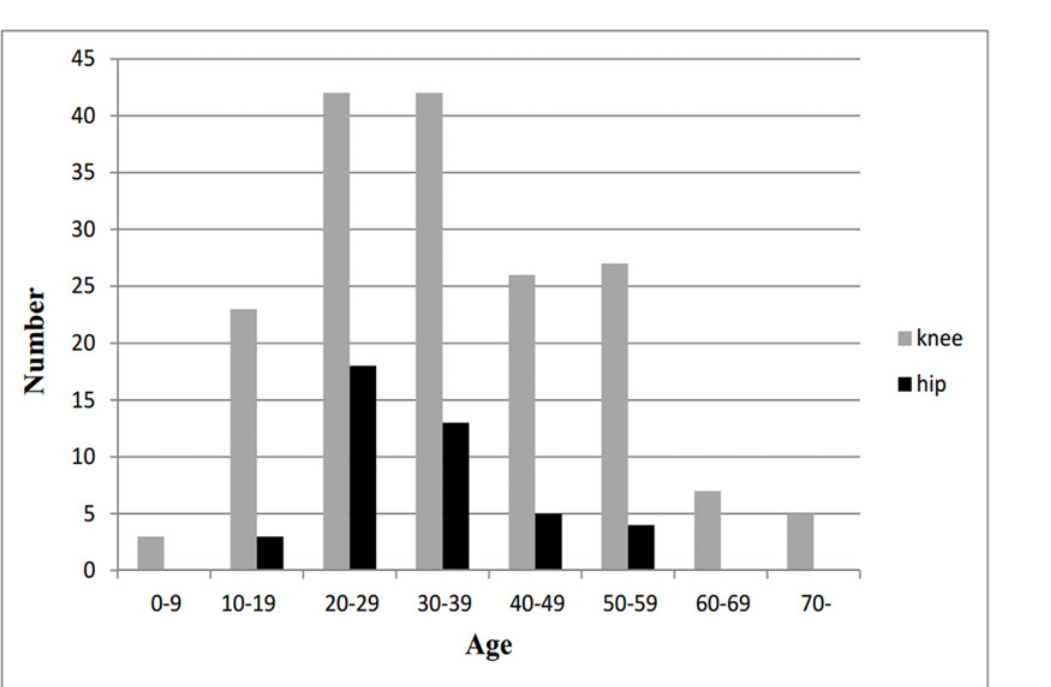
Fig 3. Age distribution of 237 PVNS patients by knee and hip.